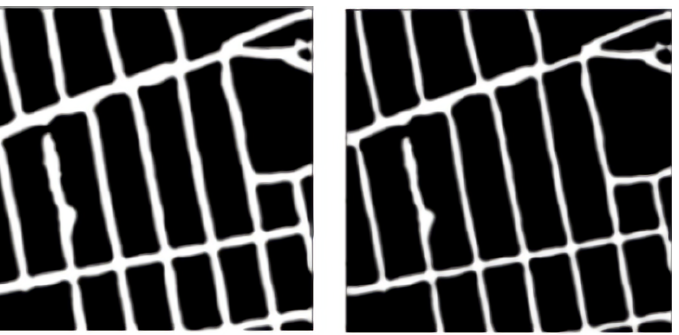
Figure 10. Small kernel erosion. The left side is the uneroded image and the right one is the small kernel-eroded image.